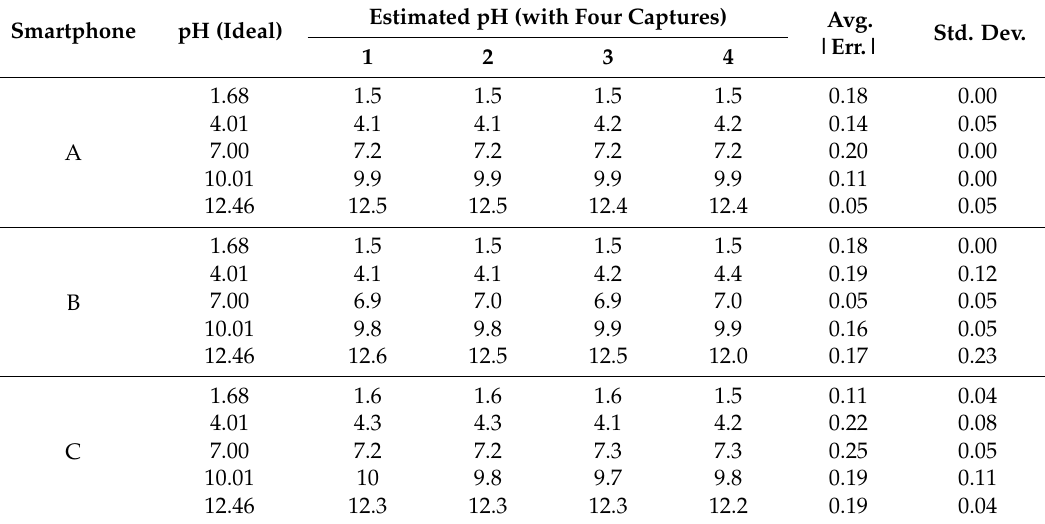
Table 1. pH estimation results for pH buffer solutions (Orion) of pH 1.68, 4.01, 7.00, 10.01, and 12.46. Smartphone